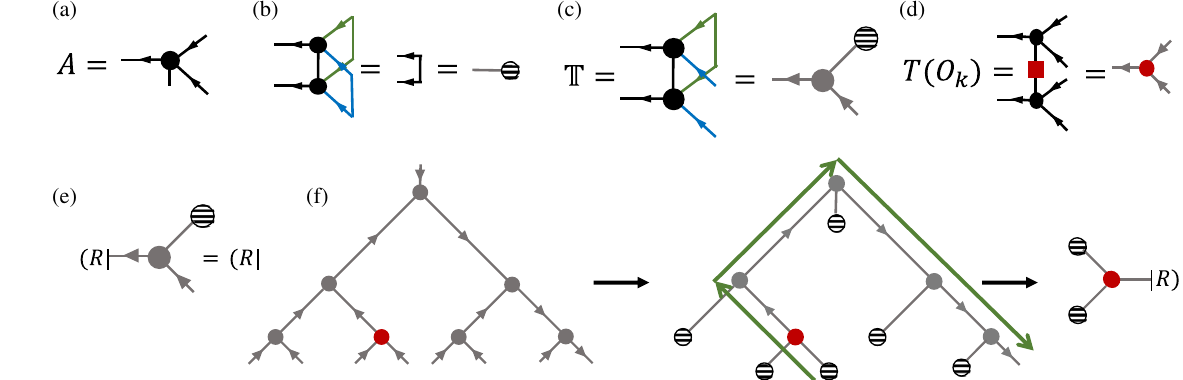
FIG. 8. Illustration of the calculation of the one-point correlation function for C ¼ 3 . The gray colored bonds denote a vectorization of the bonds pointing toward the same direction when the contractions are performed. Graphical definitions of (a) the local tensor A ; (b) the gauge symmetry [Eq. (B5)], where a hatched circle is introduced as a shorthand notation for a Kronecker delta in virtual index space; (c) the local transfer matrix [Eq. (B6)]; (d) the contraction of the local operator O by the local tensor; and (e) the right dominant k eigenvalue of the transfer matrix. (f) illustrates the calculation of Eq. (B8) in three steps. In the first step, we show a part of the tree which includes the site k , where the local operator acts. The gray colored vertices imply contracted tensors in those sites. In the second step, the gauge symmetry (b) is used, and the whole tree is reduced to a semi-infinite one-dimensional tensor network (the green line is a guide to the eye). In the final step, the infinite product of local transfer matrices is replaced by the right dominant eigenvector of the matrix; see Eq.